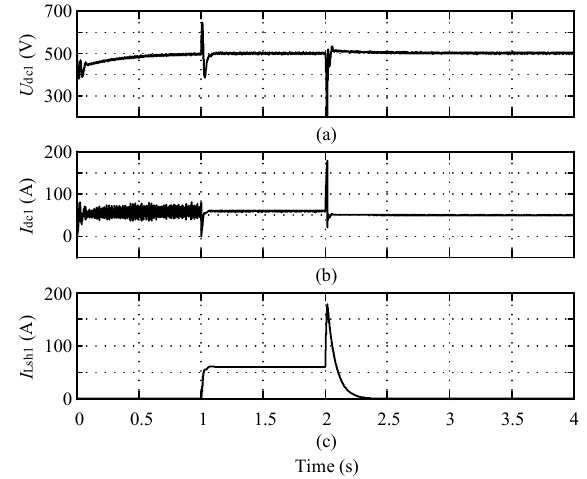
Figure 9. Simulation curve of voltage source converter (VSC) side of large current bipolar short circuit. ( a ) Capacitor C 1 voltage U dc1 . ( b ) VSC-side cable current I dc1 .( c ) Current over current-limiting inductor in FCL1 I Lsh1.